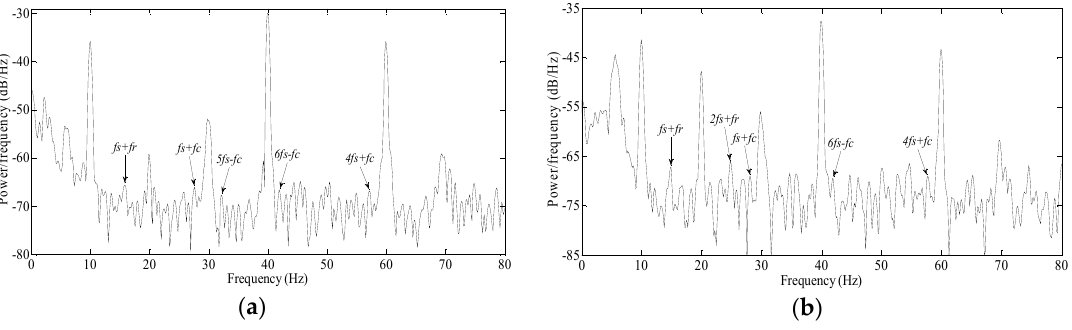
Figure 15. The squared envelope spectra based on traditional approaches when normal voltage frequency ratio is normal: ( a ) instantaneous symmetrical components; ( b ) Park's vector.